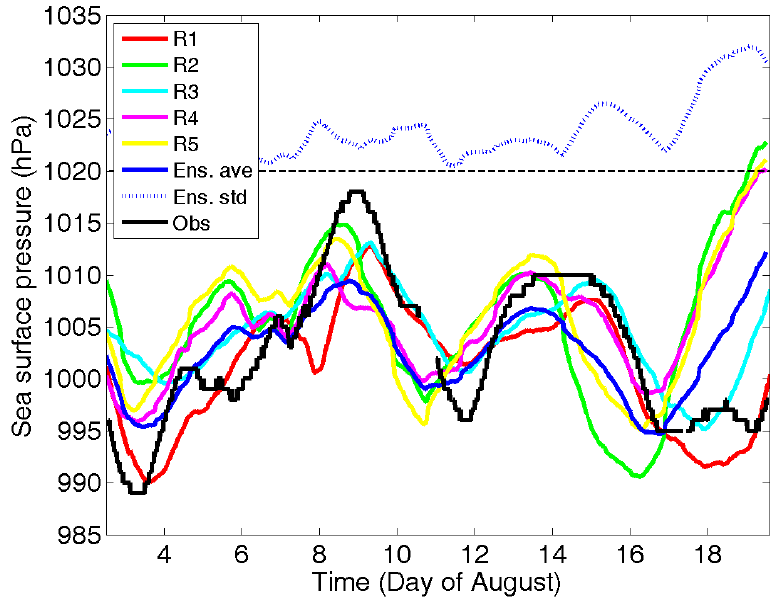
Figure 6. Mean sea-level pressure (hPa), as a function of time, from observations on the ice during the ice drift and from the ensemble average and the different members. Also shown is the ensemble standard deviation. All the model output is instant hourly while the observations are 1-minute averages. The zero-line for the model ensemble standard deviation is displaced to 1,020 hPa (straight dashed